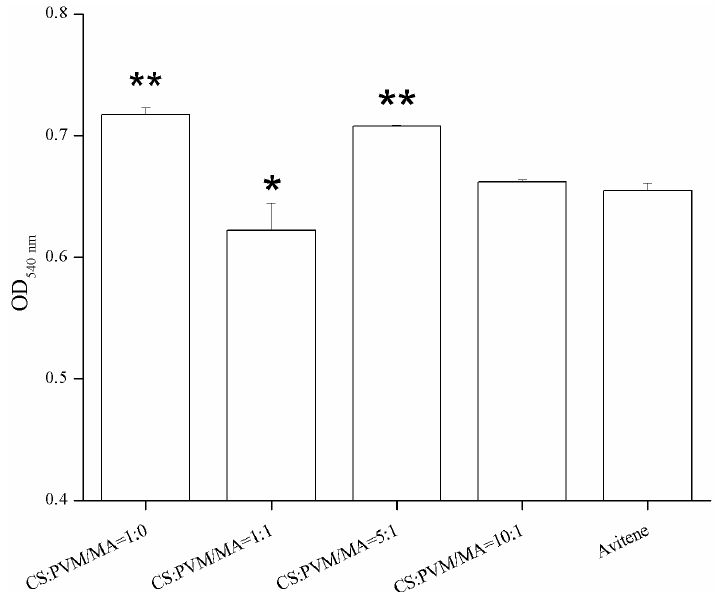
Figure 7. Results of whole blood clotting experiment. The “*” indicates a significant difference between the prepared sponge and Avitene when p < 0.05, while the “**” indicates a significant difference between the prepared sponge and Avitene when p < 0.01 (Student’s t-test, n =